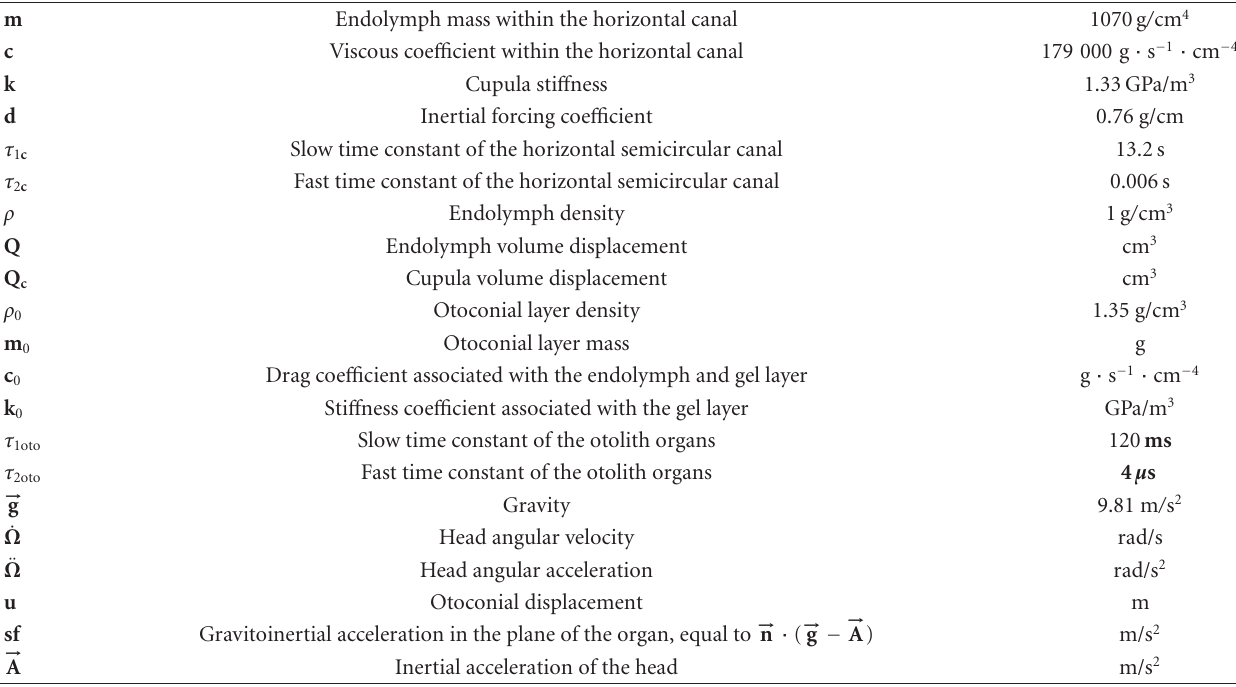
Table 1: Model parameters of the sensors (Rabbitt [7], Grant et al.